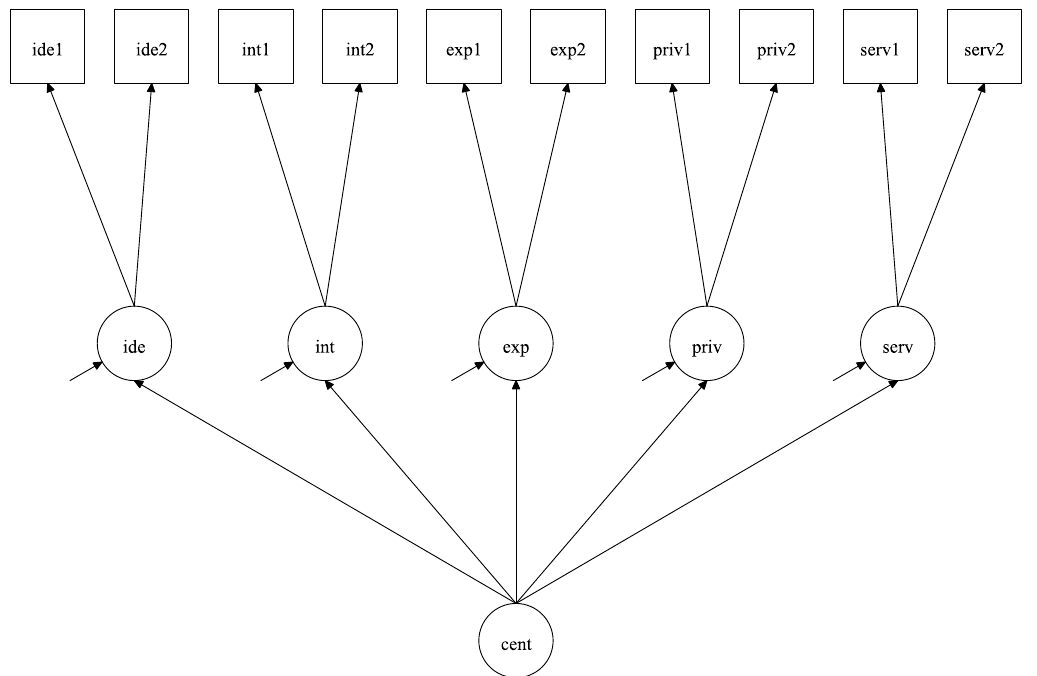
Figure 3. The confirmatory factor analysis model for the CRS-10. int = intellect; ide = ideology; serv = public practice; priv = private practice; exp = experience. The number after the item name indicates the position of the item within the core dimension items. Squares depict manifest and circles latent variables. Residual arrows are not shown for the manifest variables. Residuals for the latent variables are shown as arrows starting in blank space.